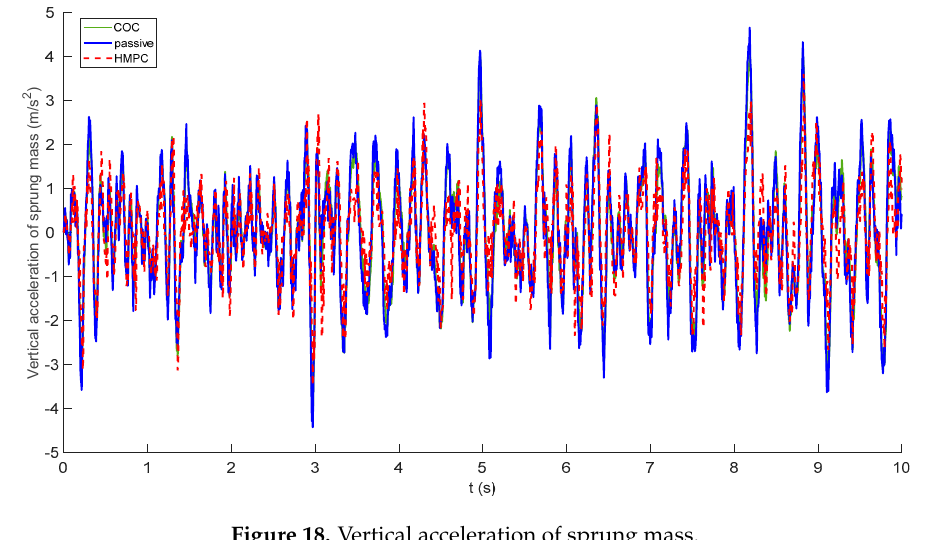
Figure 18. Vertical acceleration of sprung mass.